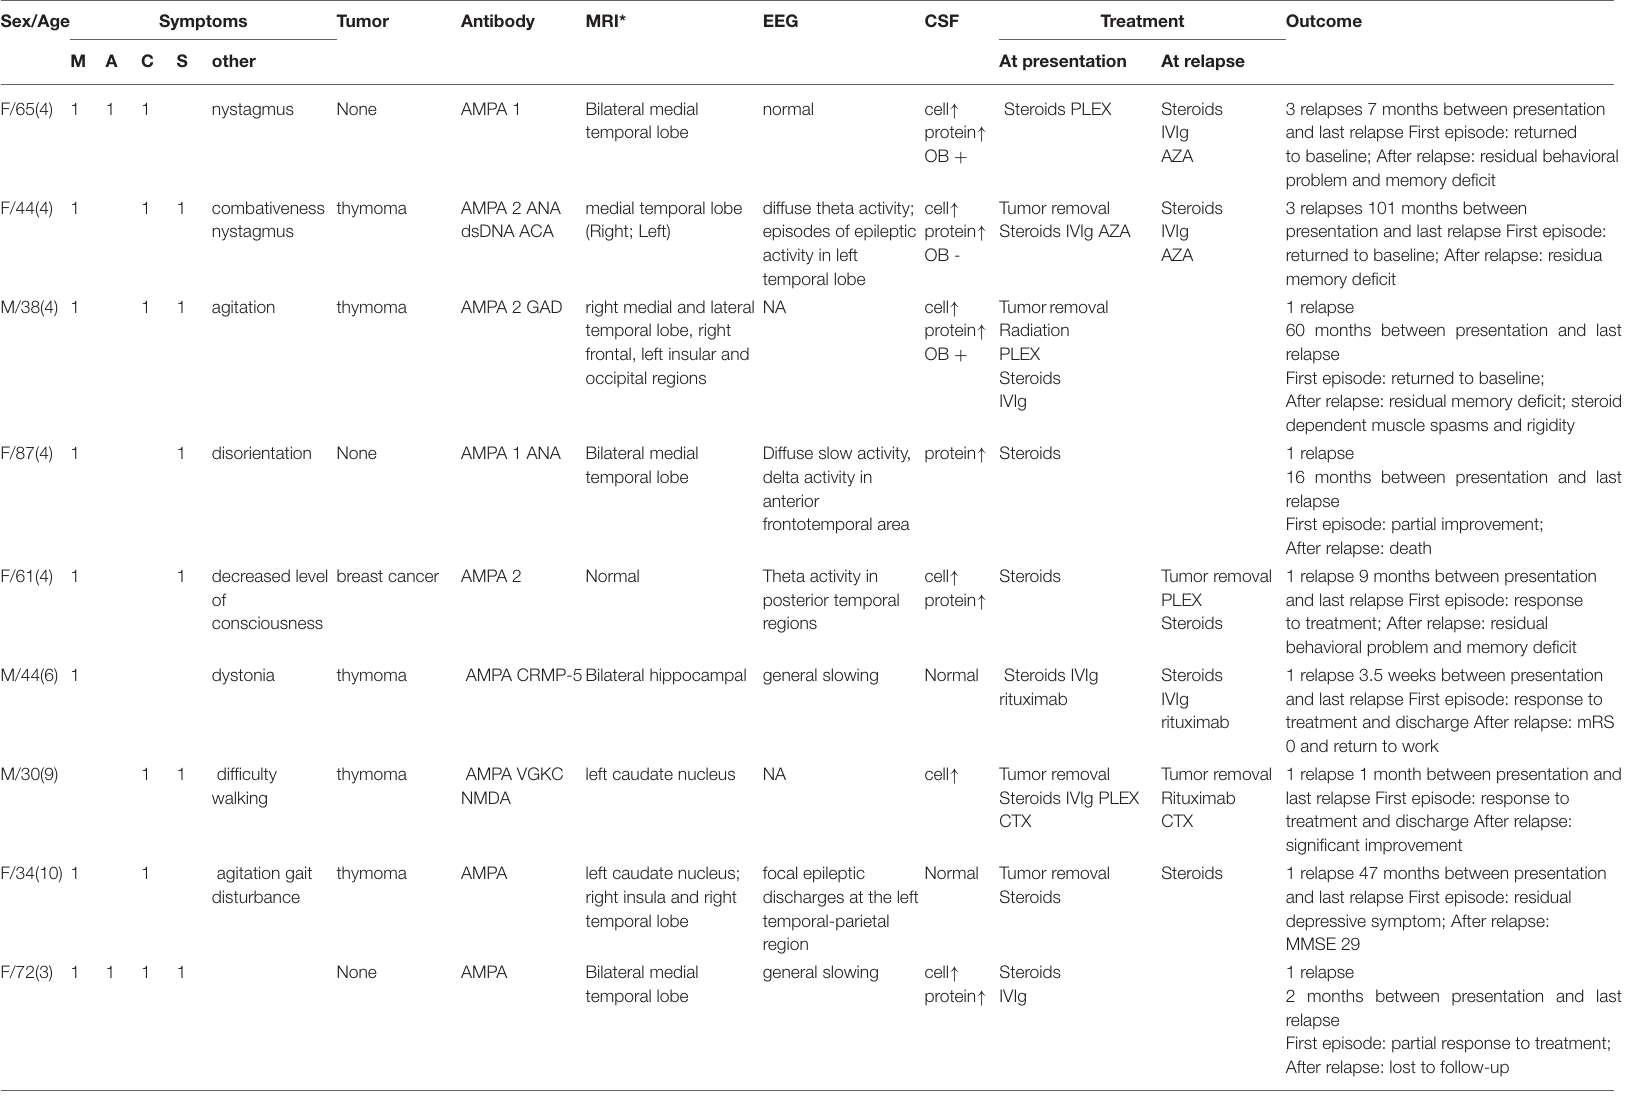
TABLE 1 | Summary of nine cases with relapse of AMPA-R antibodies encephalitis.